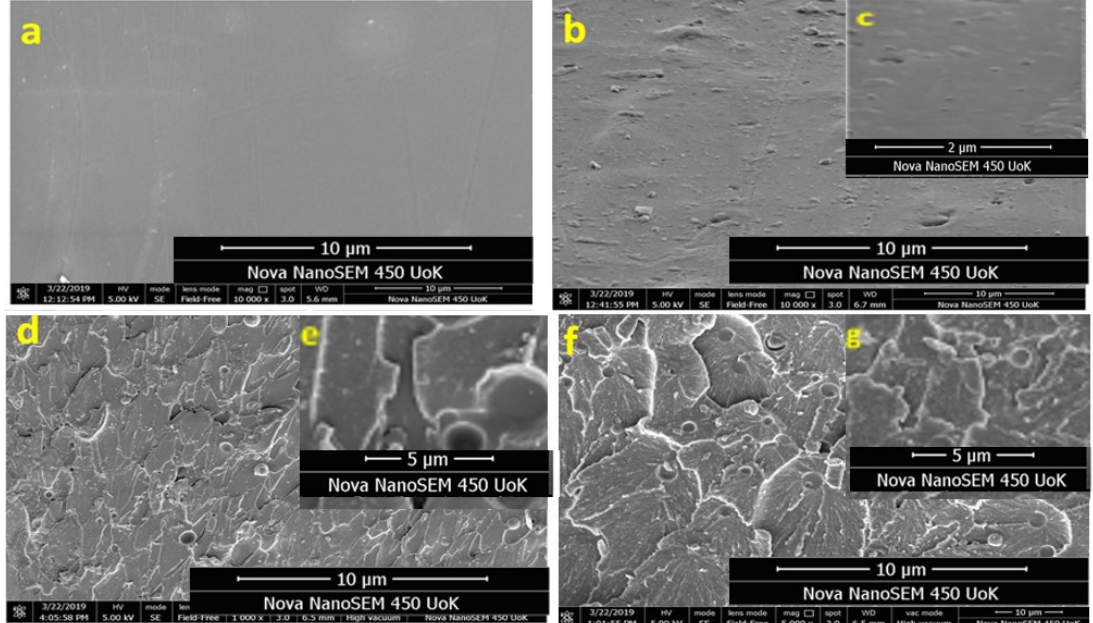
Figure 3. FE-SEM micrographs of fracture surface of ( a ) neat epoxy, epoxy/eSBS 55 blends with ( b ) 5 phr, ( c ) higher magnification, ( d ) 10 phr, ( e ) higher magnification, ( f ) 20 phr, and ( g ) higher magnification, respectively.